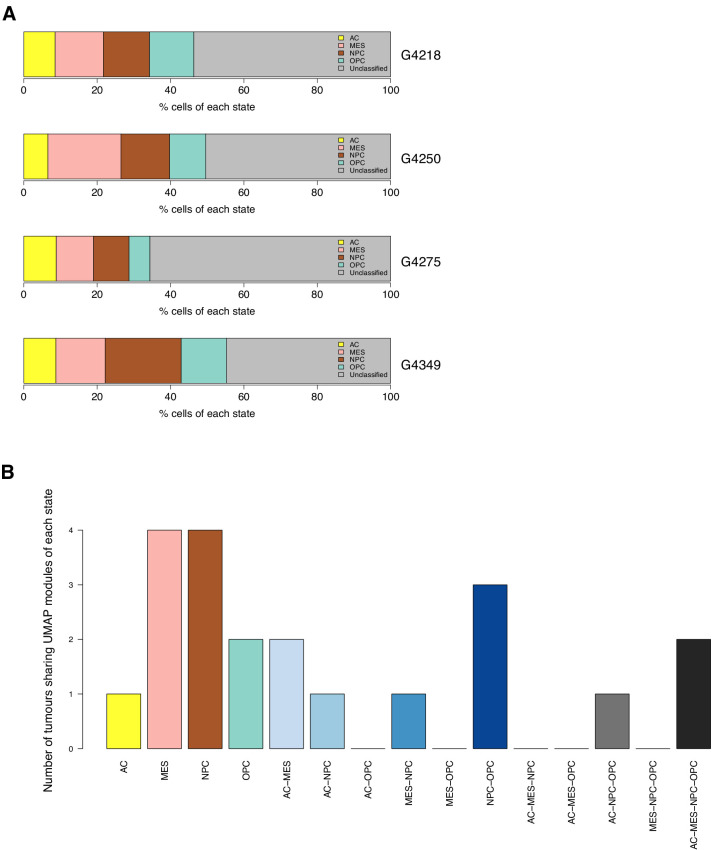
The distribution of cell states across tumor cells.(A) Percentage of each tumor’s cells significantly enriched with each state’s signature genes. (B) Number of tumors with at least one UMAP module dominated by a given cell state.